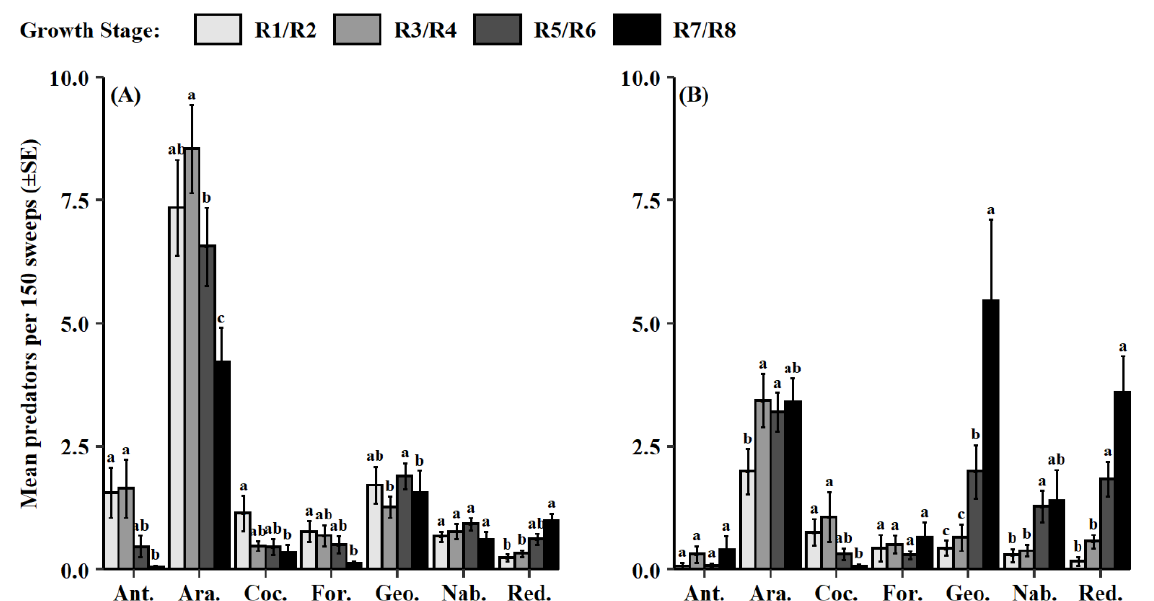
Figure 6. Mean predator count per 150 sweeps ( ± SE) for observed soybean growth stages across most common predator groups in datasets ( A ) 2012–2014 and ( B ) 2015–2018. Same letter denotes no significant difference within each predator group ( p > 0.05). Abbreviations for predator groups are: Ant. = Anthocoridae, Coc. = Coccinellidae, For. = Formicidae, Geo. = Geocoridae, Nab. = Nabidae, and Red. = Reduviidae.